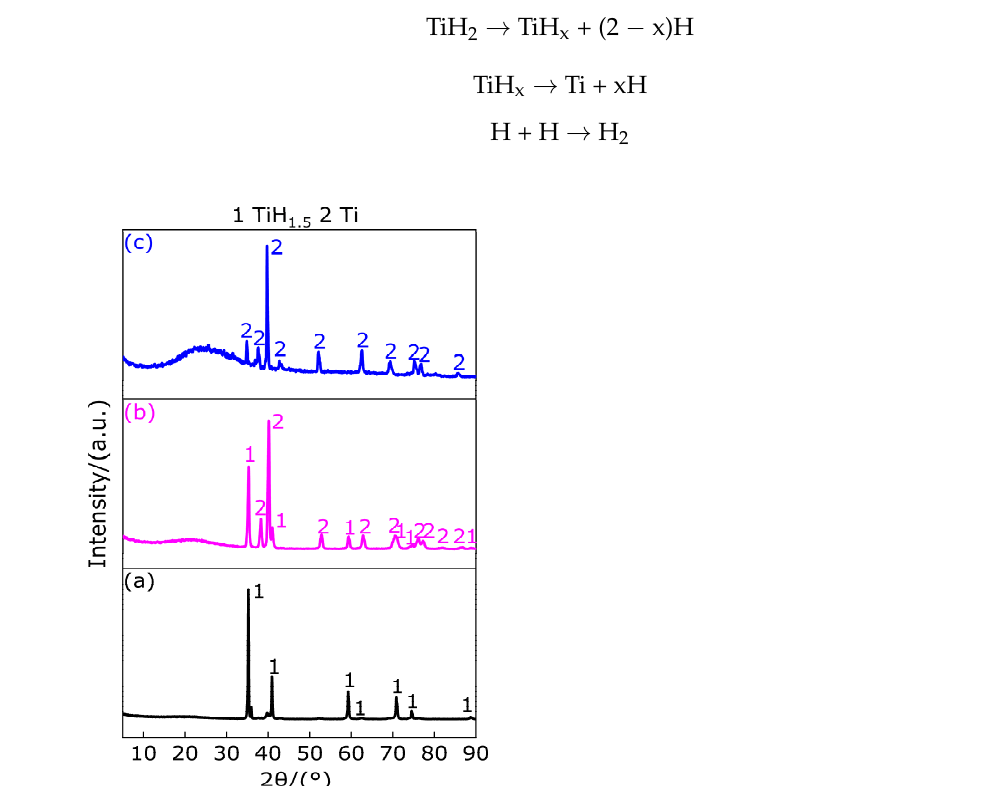
Figure 7. XRD patterns of TiH 2 at peak temperature and 1000 °C. ( a ) XRD pattern at 442.9 °C; ( b ) XRD pattern at 523.8 °C; ( c ) XRD pattern at 1000 °C. Table 8. Products of TiH 2 under argon atmosphere in different temperature ranges.